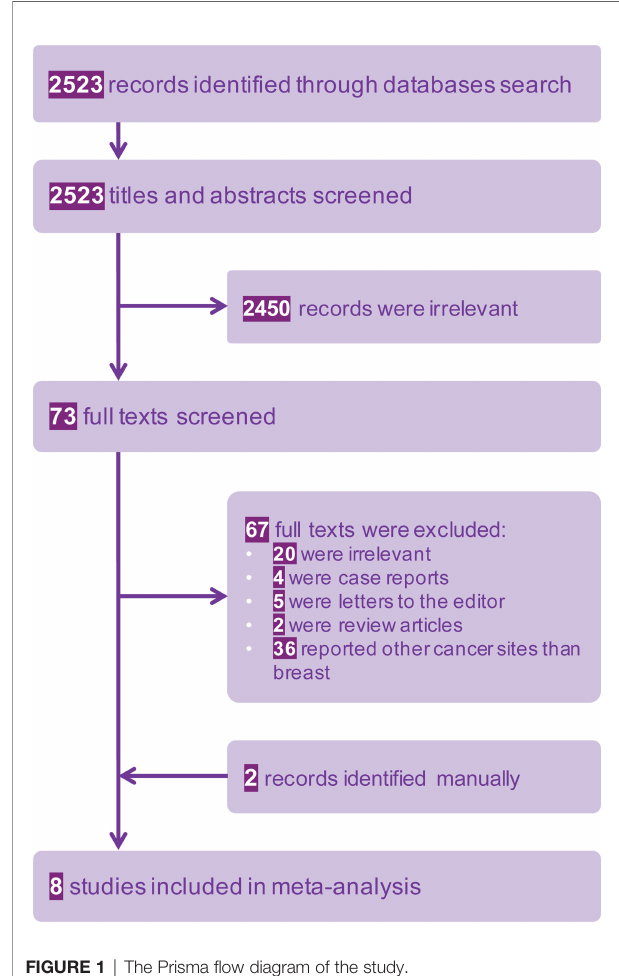
FIGURE 1 | The Prisma fl ow diagram of the